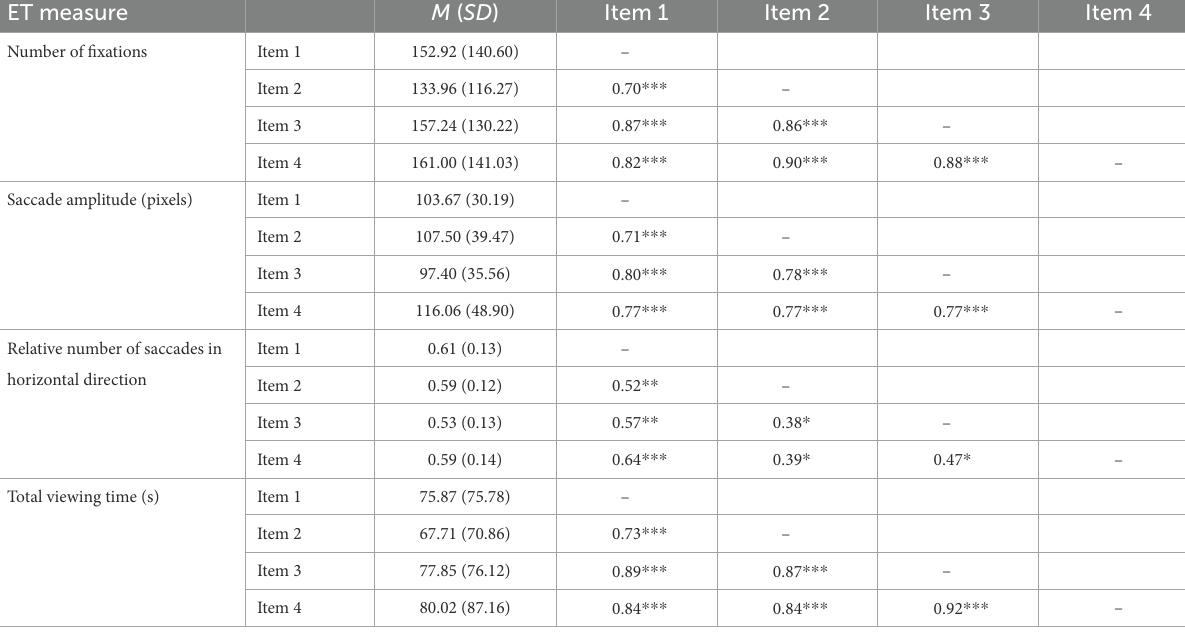
TABLE 4 Means, standard deviations, and inter-item Pearson’s correlations for eye-tracking measures. ET